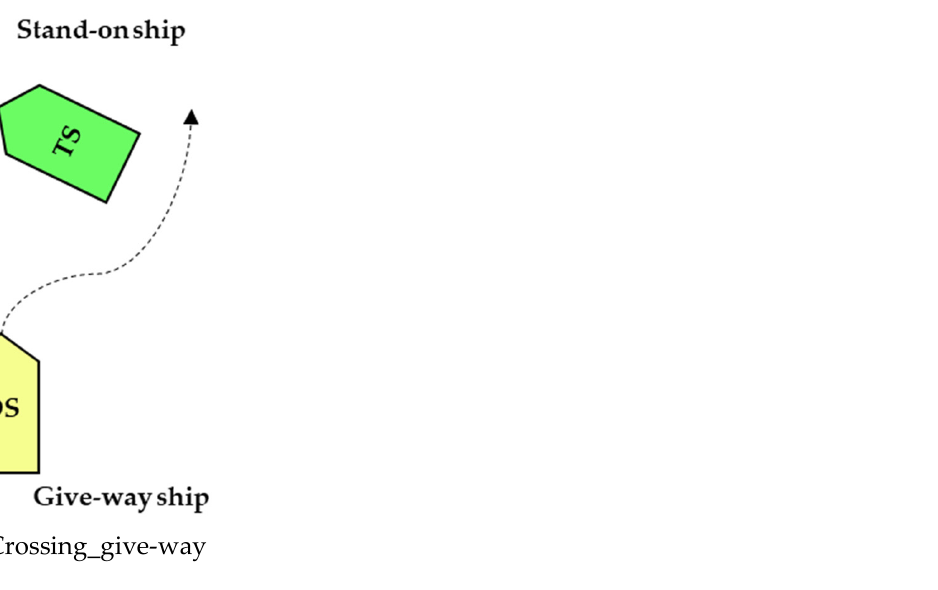
Figure 3. Three encounter situations divided by COLREGs: ( a ) Overtaking, ( b ) Head-on, and ( c ) Crossing_give-way.4.2. B-spline based collision avoidance trajectory representation. The B-spline curve is an improved version of the Bezier curve. Through a Bezier curve, a complex shape curve can be drawn. As long as the points representing the general trend of the curve are given as control turning points, a control polygon can be drawn from these points, and then the desired curve can be drawn by approximating the polygon through the Bezier formula.